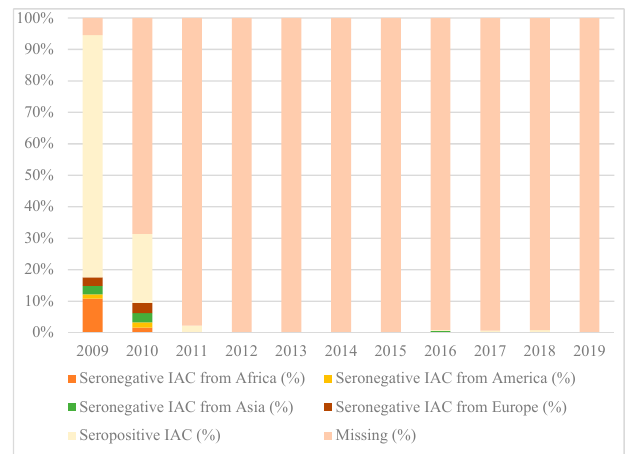
Figure 1. Percentages of seropositive and seronegative children in the study for diphtheria, by year of the first visit in Italy and country of origin.